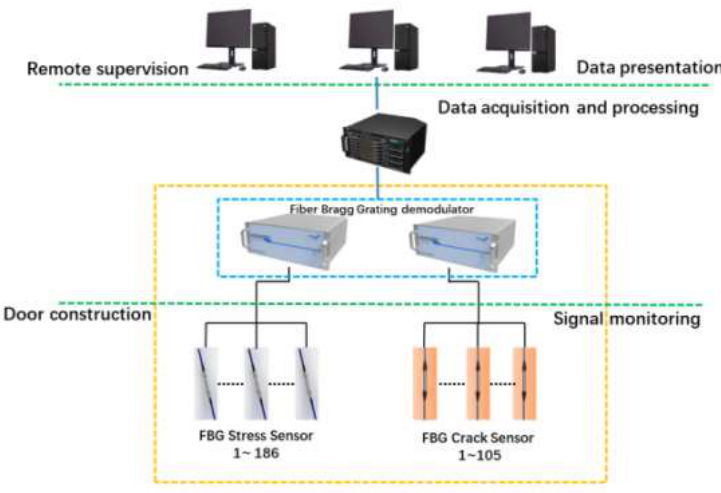
Figure 2. On-line monitoring system for the miter gate.